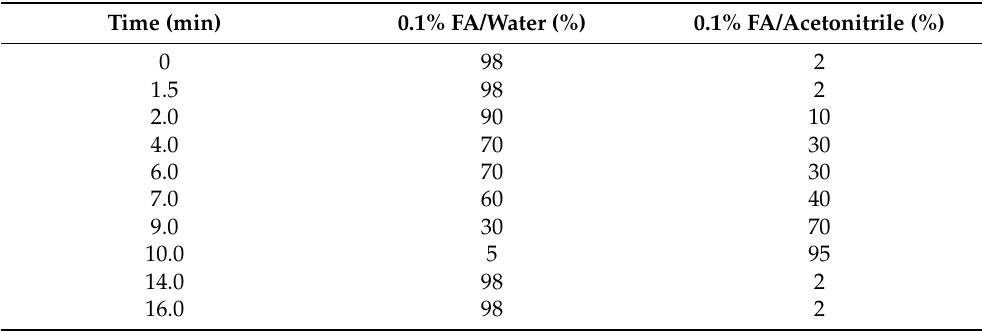
Table 1. The analysis condition of kaempferol, hesperidin, naringin, p-coumaric acid, caffeic acid, and chlorogenic acid. FA—formic